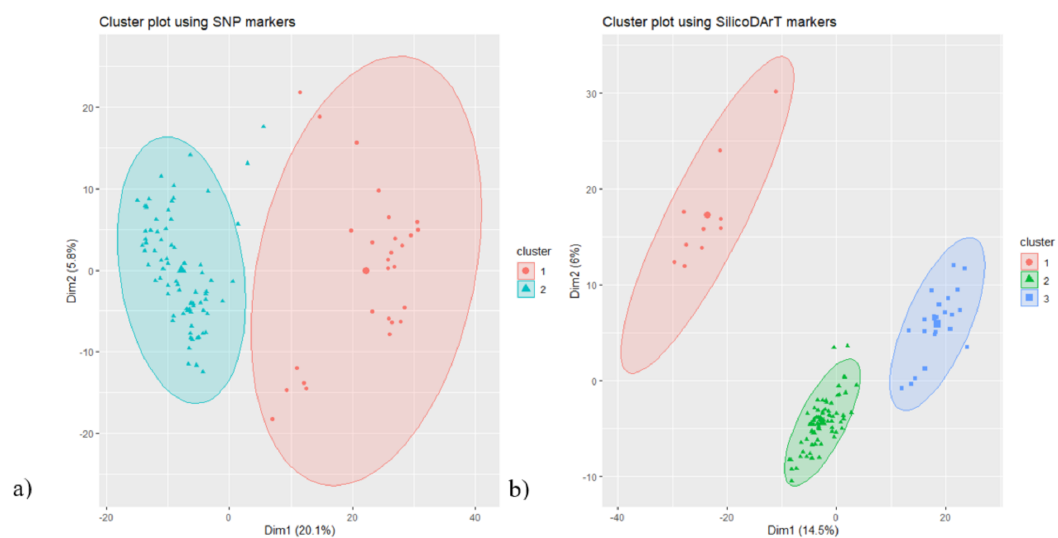
Figure 5. Cluster plots showing population clusters using ( a ) SNP and ( b ) SilicoDArT markers.